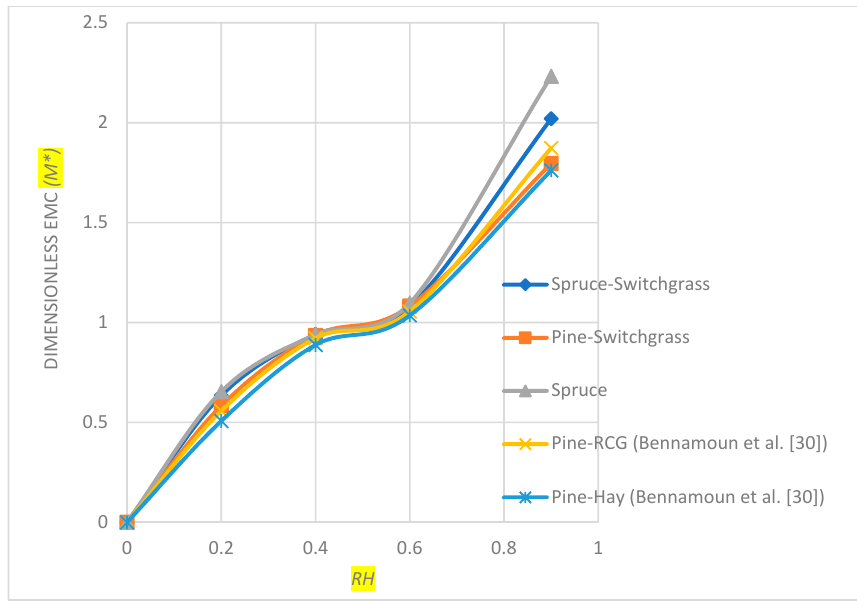
Figure 2. Dimensionless EMC for the mixed biomass pellets and comparison with other pellets.